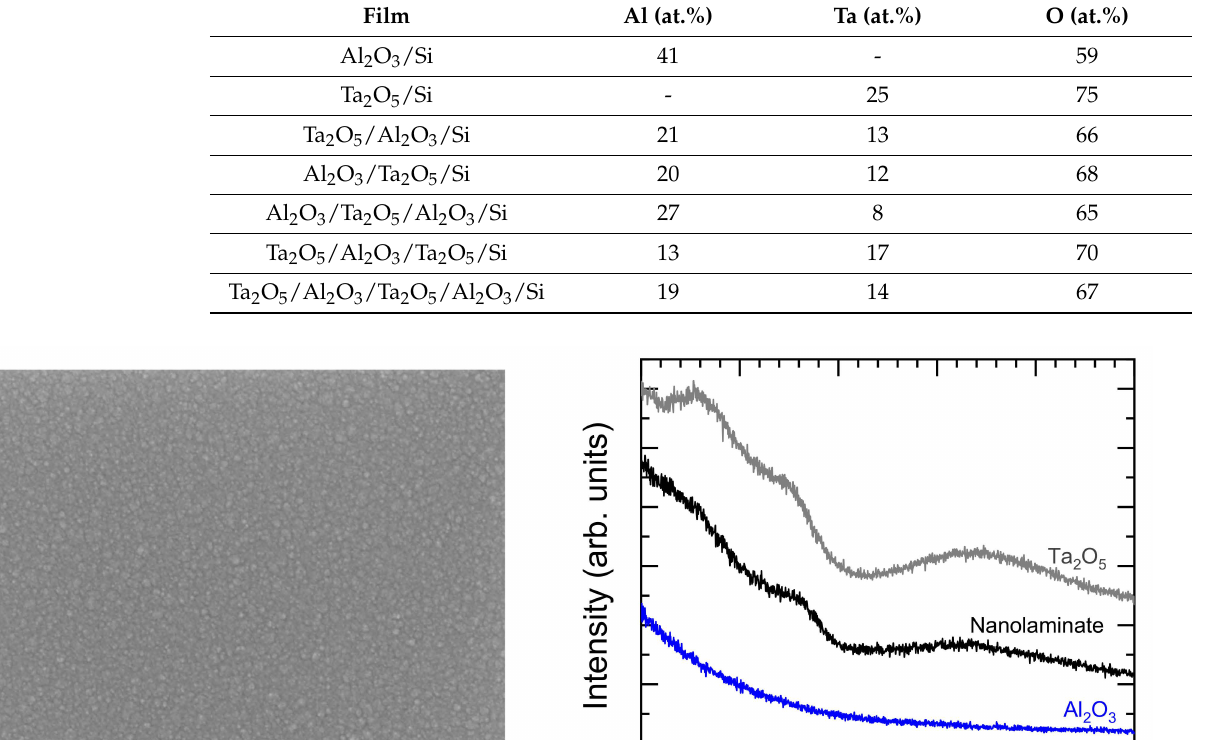
Table 1. Average density of the oxides was 3.1 ± 0.2 g/cm 3 and 8.4 ± 0.2 g/cm 3 for Al 2 O 3 and Ta 2 O 5 layers, respectively. Table 2. Elemental composition of the ≈ 70 nm thick films according to XRF.